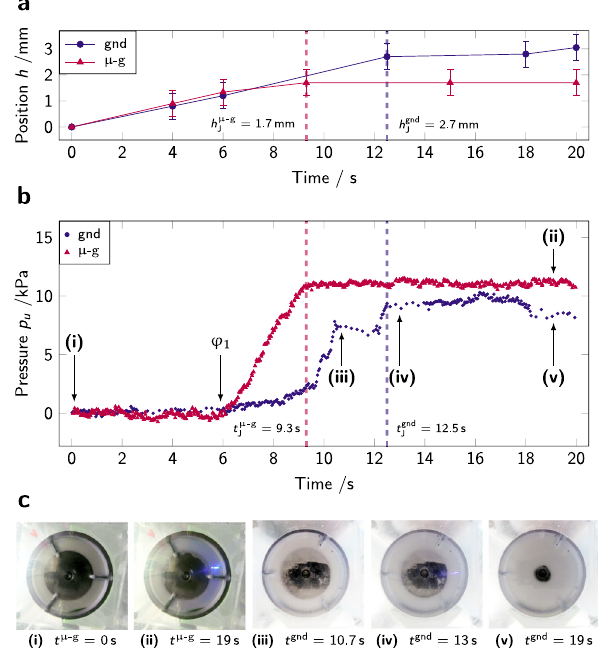
Fig. 2 Time evolution of piston position and pressure in powder cell. a Piston position in height as a function of time. Error bars represent the experimental precision in optical measurement. b Pressure recorded by the top sensor during the fi rst step up of the piston, on-ground (blue disks, gnd), and in microgravity (red triangles, μ -g). The jamming times t J are marked by vertical dashed lines, as well as φ 1 (see the body of the text) and fi ve points of interest that correspond to c , images (i – v). (i) and (ii) are images from the bottom of the experiment cell looking up in microgravity (snapshots taken by the authors); (iii), (iv), and (v) on-ground. The piston is black and the PS powder, white. The clearly visible piston at all times in microgravity (i, ii, iii) indicates the absence of powder fl ow below the piston, different from the behavior on-ground (iv,